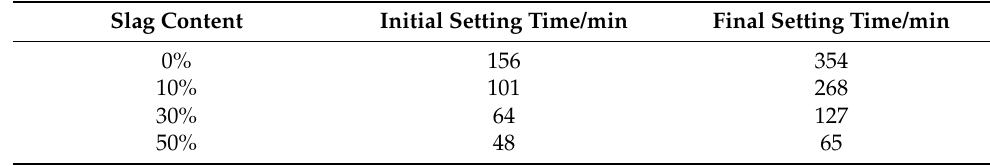
Table 3. Setting time of different slag content.